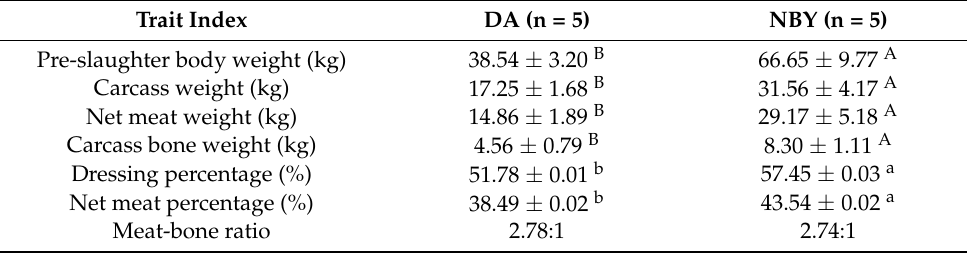
Table 1. Meat production performance indices of DA and